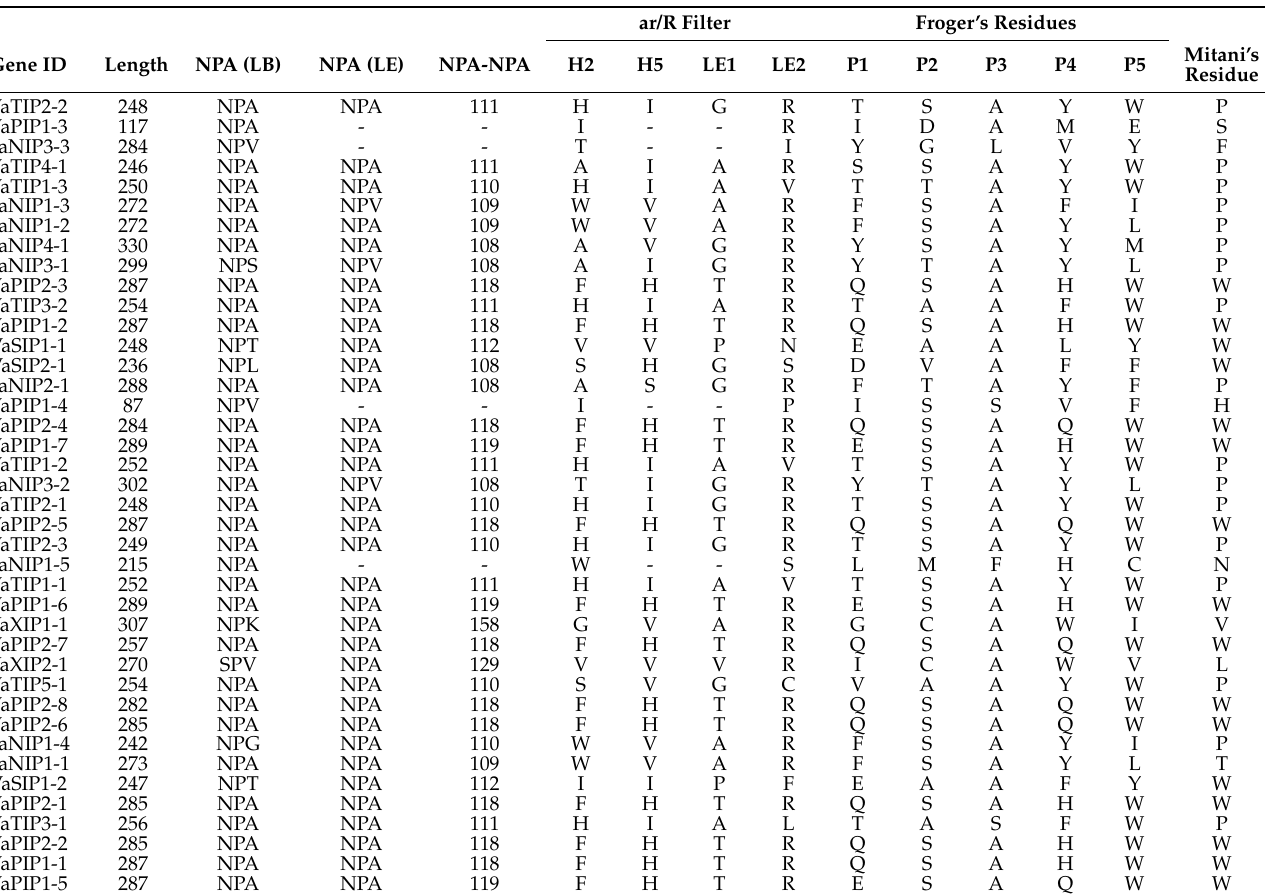
Table 2. Details of the NPA domains, ar/R selectivity filter, and Froger’s and Mitani’s residues identified in the Vigna angularis